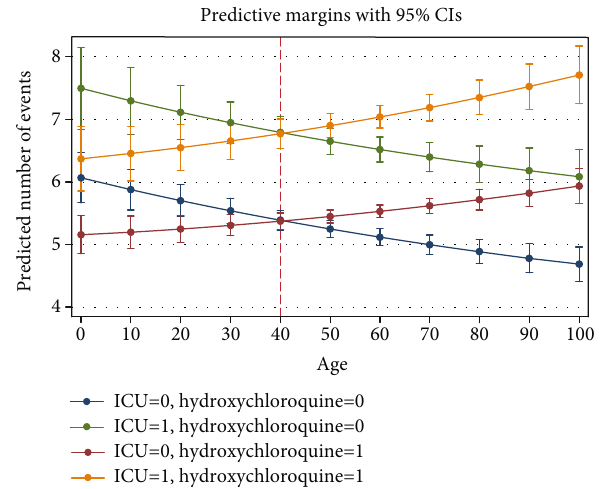
Figure 10: Association of hydroxychloroquine with LOS based on age and ICU admission (from Poisson regression of Table